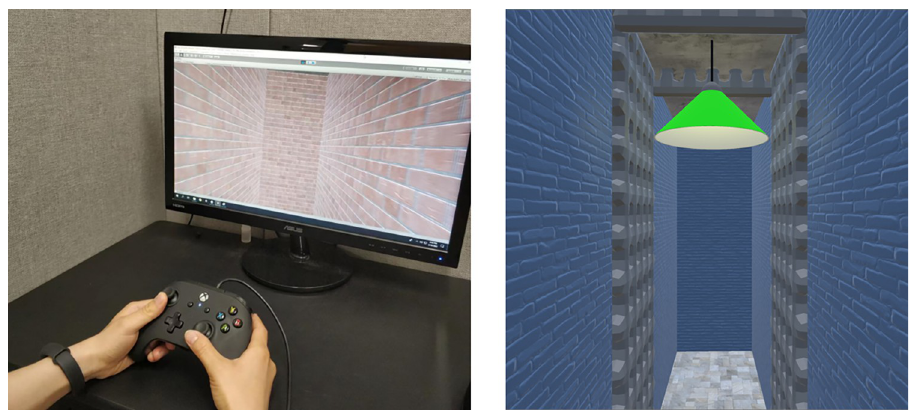
Fig 13. Experimental setup with the Xbox and example views of the intersection in Experiment